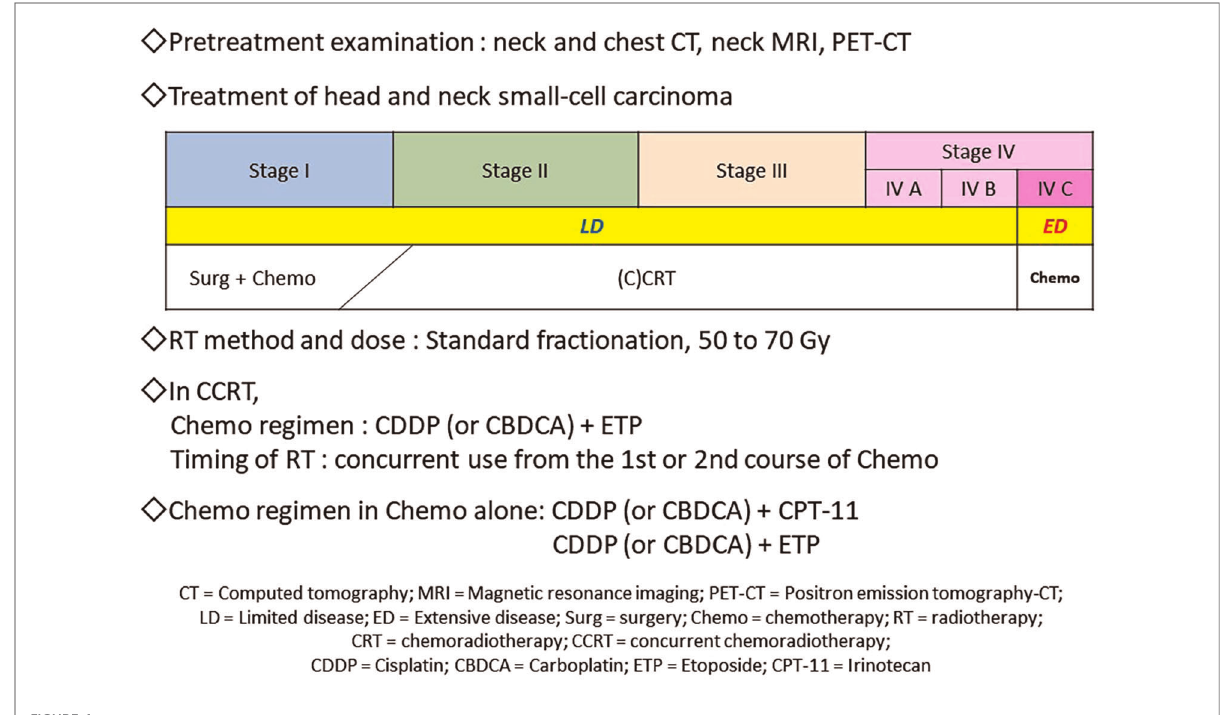
FIGURE 4 Proposal of the diagnostic and treatment algorithm of head and neck small-cell carcinoma. Regarding pretreatment examinations, neck and chest CT, neck MRI, and PET-CT are necessary and suf fi cient for deciding stages and ruling out small-cell lung carcinoma. For the fi rst-line treatment, CRT, especially CCRT is recommended for Stage ≤ IV-B disease; RT 60 – 70 Gy by standard fractionation and Chemo with CDDP or CBDCA+ETP (4 courses) may be administered. Regarding the timing of RT, concurrent use from the fi rst or second course of Chemo may be recommended. In Stage IV-C, Chemo alone, such as the CDDP or CBDCA+CPT-11 or ETP regimens, is